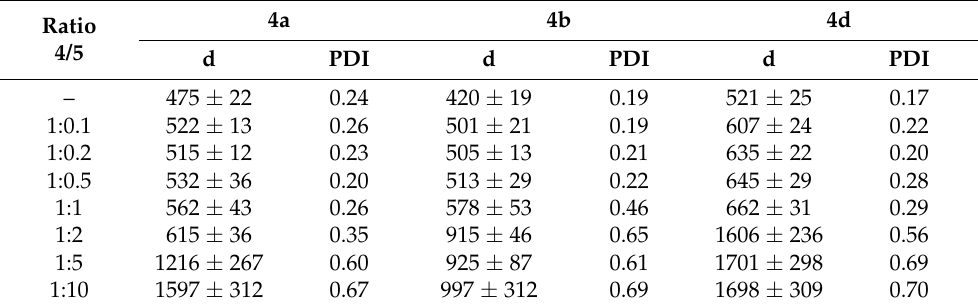
Table 1. Sizes of aggregates (average hydrodynamic diameter) in a methanol/water (2:1) mixture of compounds 4a,b,d (1 × 10 − 3 M) in the presence and in the absence of pillar[5]arene 5 , obtained by the DLS method.